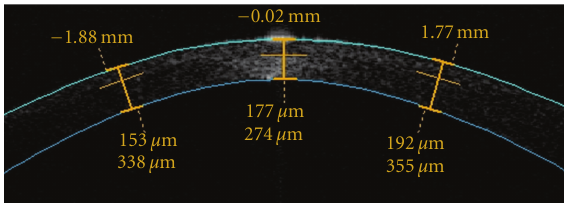
Figure 1: Optical coherence tomography showing a postoperative flap thickness of 177 µ m, producing a residual stromal bed of 274 µ m in the right eye. Data would help in case of an enhancement is